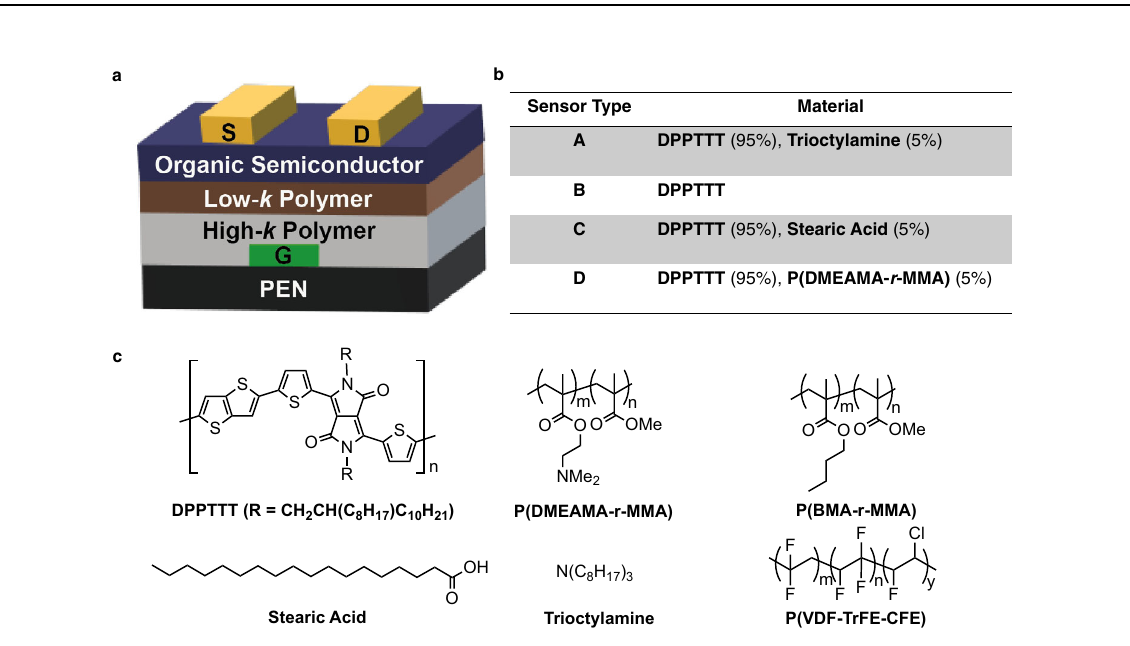
different types of OFET (A – D). c Structures of all of the materials used in the OFET devices — low- k polymeriscross-linkedP(BMA-r-MMA)andhigh- k polymerisP(VDF- TrFE-CFE).